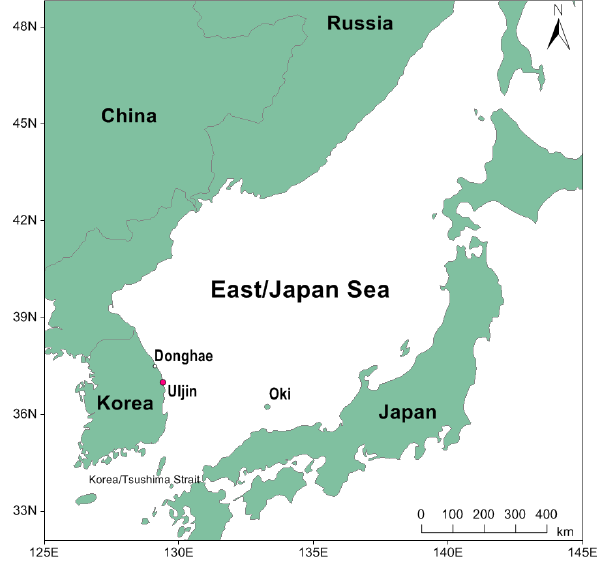
Figure 1. Map showing the location of Uljin (sampling site; 37 ◦ N, 129.4 ◦ E), Donghae (37.5 ◦ N, 129.1 ◦ E), and Oki Island (36.3 ◦ N, 133.2 ◦